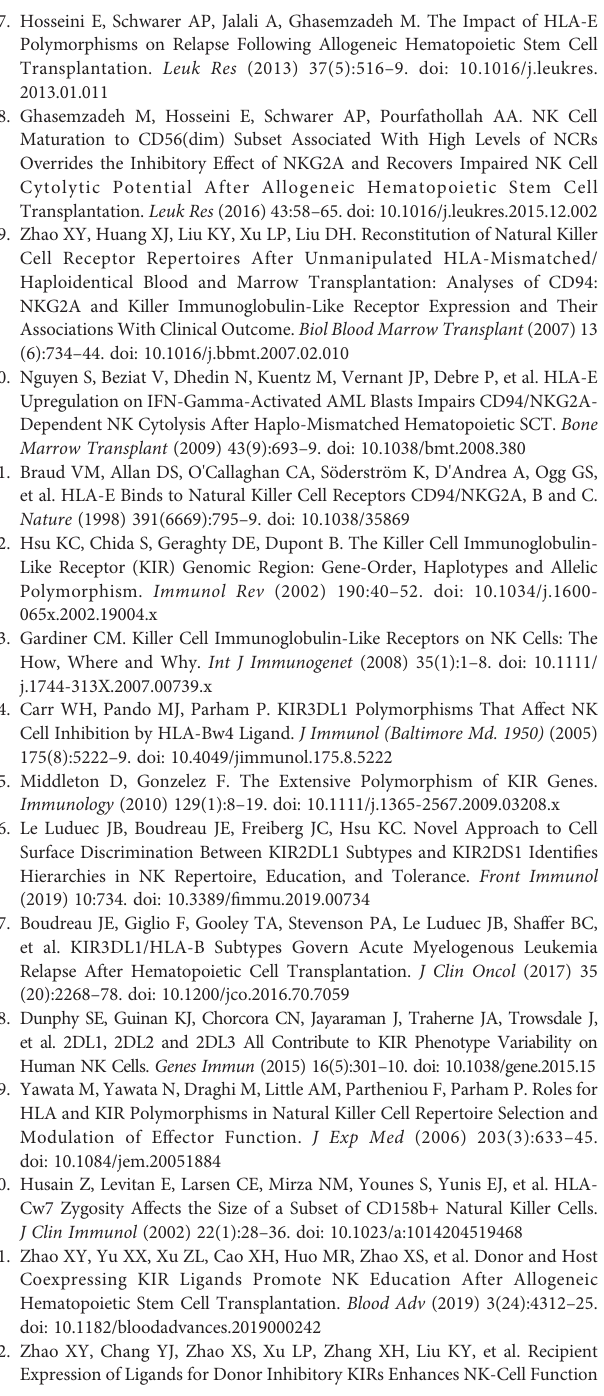
Supplementary Figure 7 | KIR typing was irrelevant regarding the expansion of KIR2DL2/L3 single-positive/NKG2C + NK cells. PB, peripheral blood sample Patient and donor DNA were prepared from the peripheral blood mononuclear cells (PBMCs) for pretransplant HLA typing and stored at -40°C, performed according to instruments.There was no obvious correlation between the proportion of KIR2DL2/L3 single-positive/NKG2C + NK cells among NK cells and the proportion of NKG2C + NK cells among NK cells from patients in the general cohort on Day 30 (n=98), Day 90 (n=118) and Day 180 (n=107).